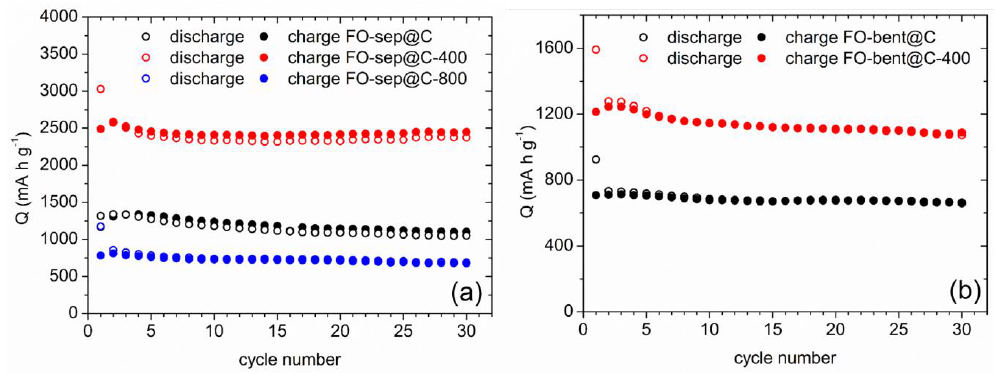
Figure 9. Specific capacity vs. cycle number for different samples of ( a ) FO-Sep@C and ( b ) FO-Ben@C.